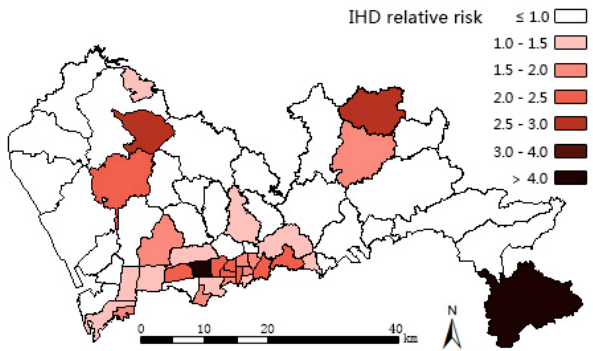
Figure 4. Results obtained using Model 1. Spatial patterns of posterior estimates of overall IHD relative risk (RR).